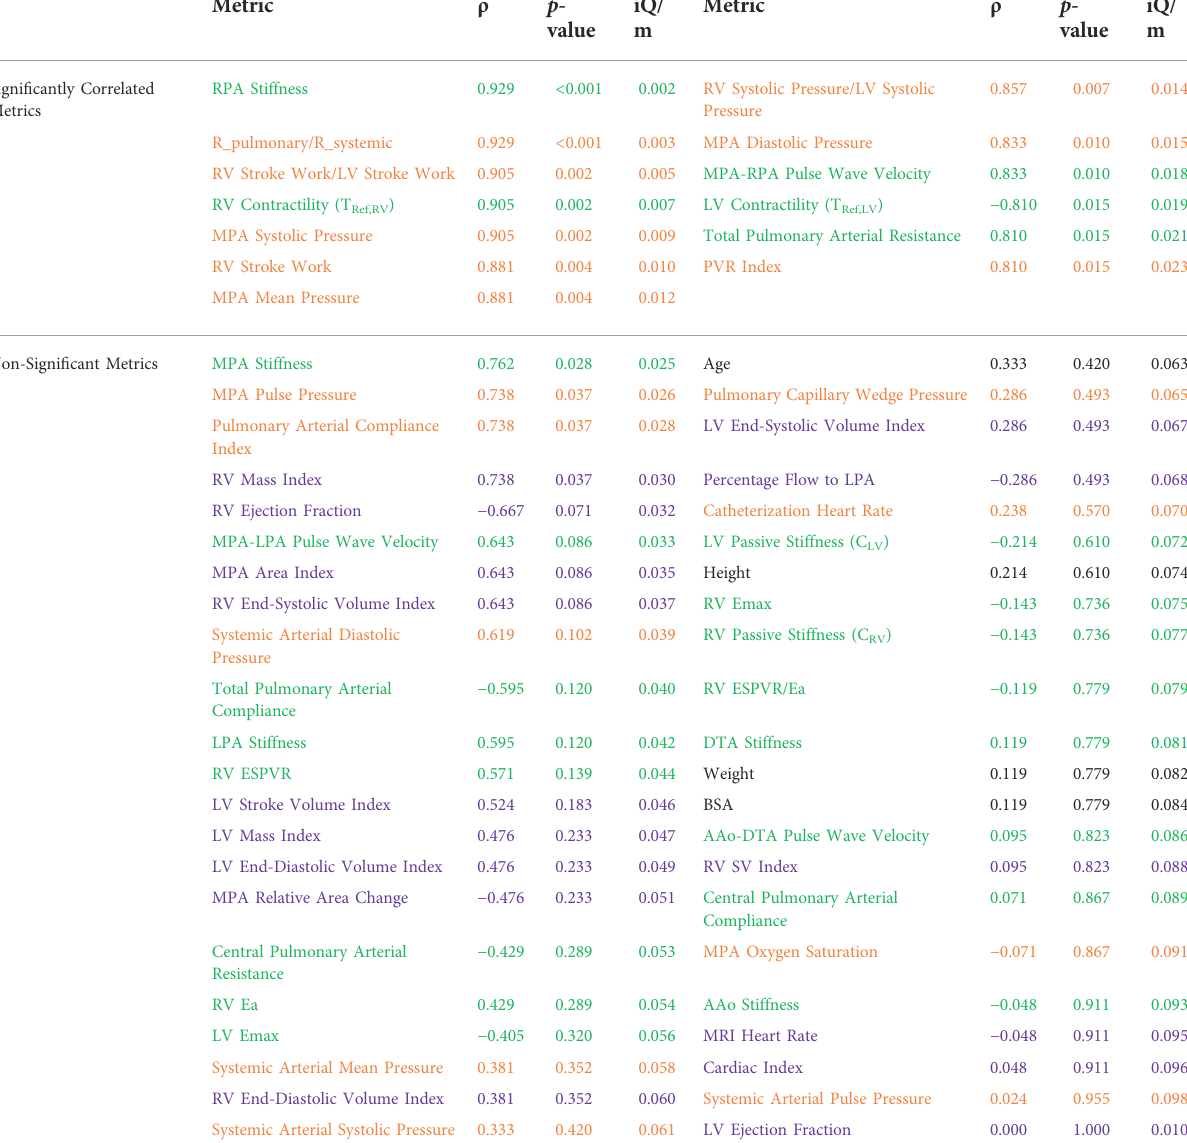
TABLE 5 Spearman ’ s rank correlation coef fi cients ( ρ ), p -values, and Benjamini-Hochberg critical value (iQ/m) of each data-derived and model- derived metricresultingfroma comparison toclinicaldiseaseseverity rankingsareshown in twocolumns.Ametricis statistically signi fi cant ifits p -value is lower than its Benjamini-Hochberg critical value